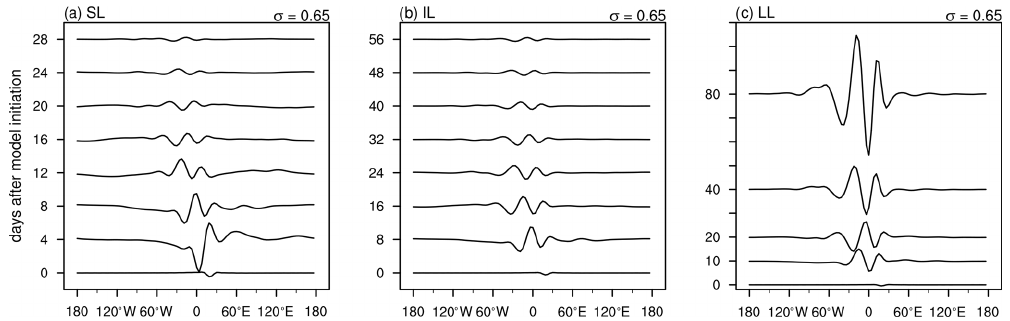
Figure 11. Streamfunction (10 5 m 2 s − 1 ) averaged over 10–20 ◦ N at σ = 0 . 65 and plotted as a function of longitude for selected days for short- (a) , intermediate- (b) , and long-lived (c) simulations. Each day’s streamfunction is offset along the ordinate for